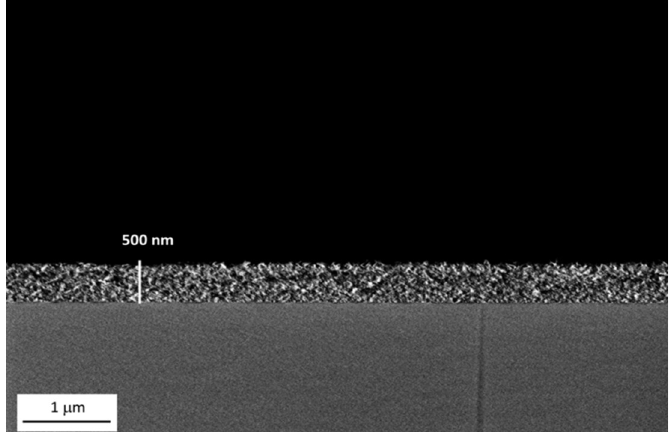
Figure 5. FE-SEM image of the boehmite film thickness. Scale bars are reported.